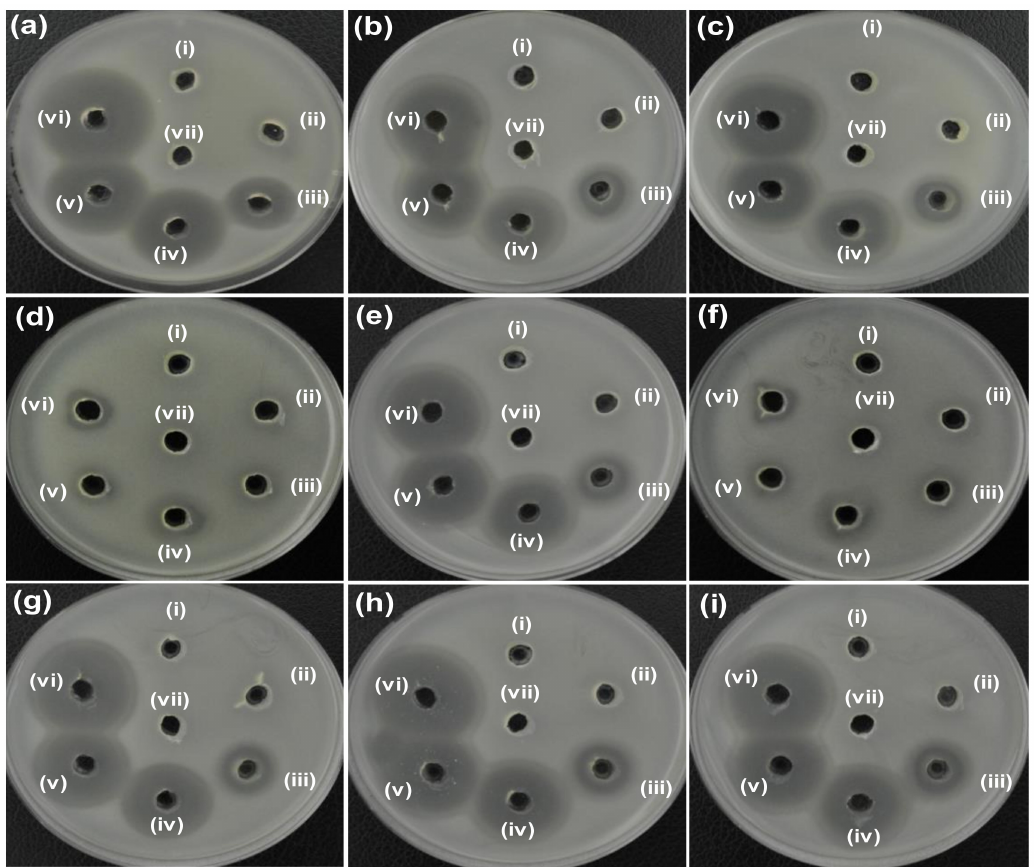
Figure 5. Zone of inhibition (ZOI) of ZO samples against ( a ) S. aureus , and ( b – i ) MRSA1-MRSA8. (i), (ii), (iii), (iv), (v), (vi), and (vii) represents ZO, AZO, AZE1, AZE2, AZE3, erythromycin (Ery), and deionized water (DW), respectively in all figures. Diameter of ZOI is also displayed in Table 2 (average from n =